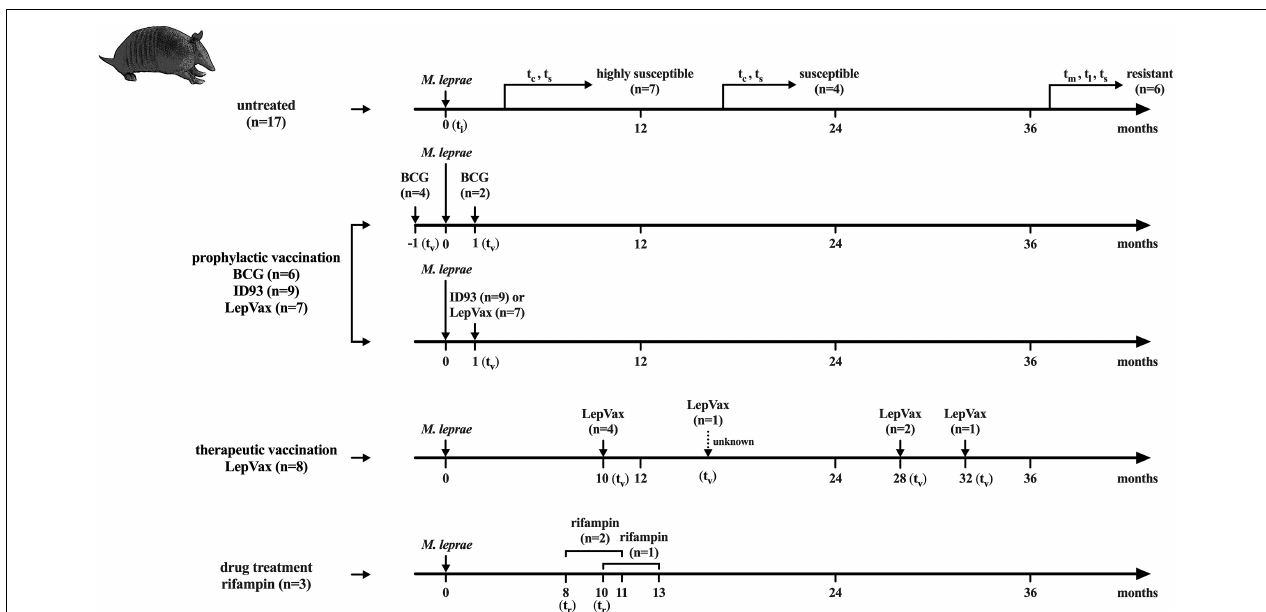
FIGURE 1 | Flowchart of infection, treatment and sampling, Sample collected at several time points from 52 nine-banded armadillos ( Dasypus novemcinctus ) infected with 1 × 10 9 M. leprae bacilli from strains: NHDP 63 ( n = 33), NHDP 98 ( n = 7), or Brazil 4923 ( n = 11). One animal was infected in the wild. M. leprae infected armadillos that were untreated and unvaccinated ( n = 17) were divided into 3 groups according to M. leprae dissemination and disease progression after inoculation: highly susceptible (within 12 months; n = 7), susceptible (within 24 months; n = 4), and resistant (after more than 36 months; n = 6); Treated animals were divided into: Armadillos vaccinated with BCG 1 month pre- ( n = 6) or post- ( n = 2) infection; Armadillos prophylactically vaccinated with ID93 ( n = 9) or LepVax ( n = 7) 1 month post-infection; Armadillos therapeutically vaccinated LepVax ( n = 8) 10–32 months post-infection; Armadillos treated for 3 months with rifampin 8 or 10 months post-infection ( n = 3). For the animal that was infected in the wild and LepVax vaccinated, the inoculation time (t i ) and interval between t i were unknown.